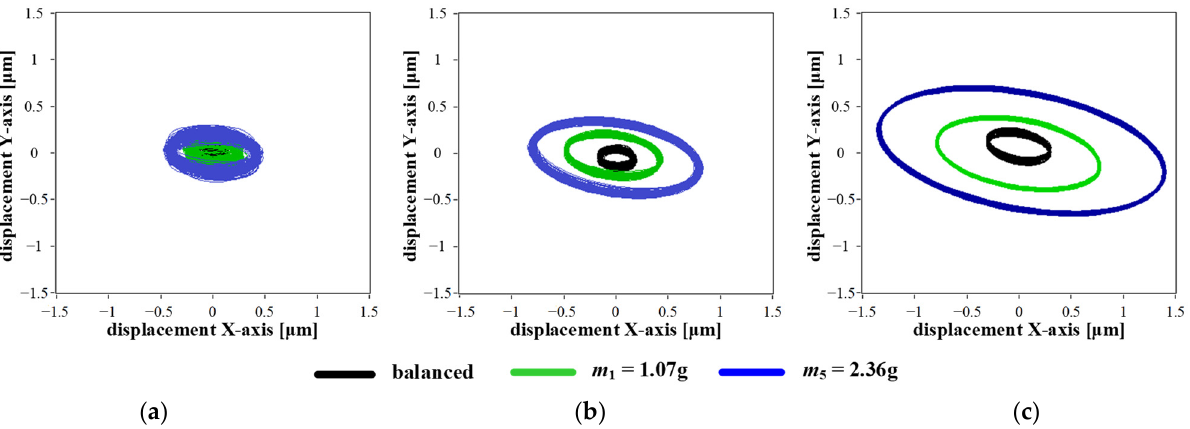
Figure 14. Sample orbits recorded for speeds of 900 rpm ( a ), 1200 rpm ( b ) and 1500 rpm ( c ) with changing unbalance mass.